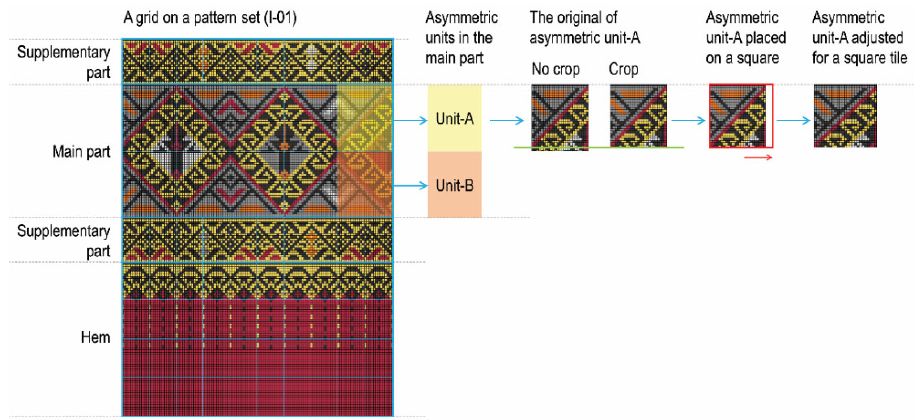
Figure 6. Asymmetric units and adjustments on a square tile. (Illustration by Kunkhet and Chud ‐ asri).